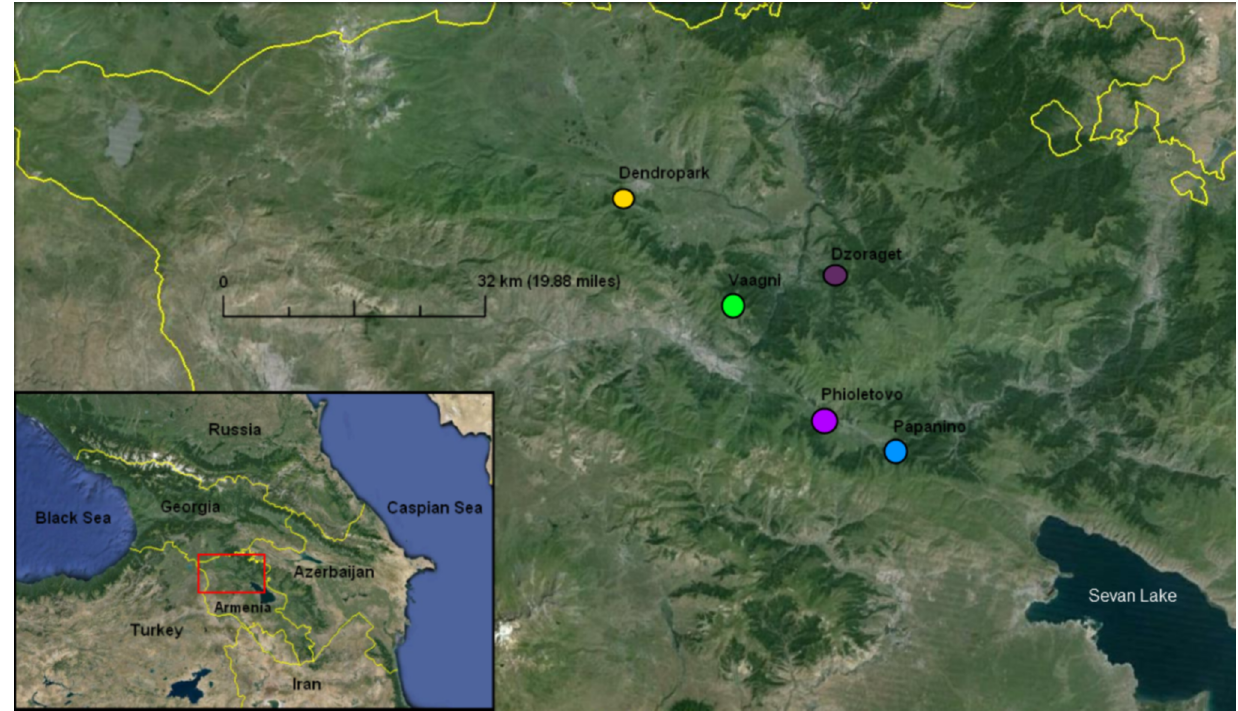
Figure 1. Map of Armenia with the distribution of localities from which parthenogenetic Darevskiadahli populations were collected. Sampling localities are indicated by different colours. Papanino ( + 40 u 42 9 27.76 0 , + 44 u 45 9 43.89 0 ), Phioletovo ( + 40 u 44 9 29.53 0 , + 44 u 39 9 31.25 0 ), Vaagni ( + 40 u 52 9 19.16 0 , + 44 u 31 9 28.60 0 ), Dzoraget ( + 40 u 54 9 15.02 0 , + 44 u 40 9 37.78 0 ), Dendropark ( + 40 u 59 9 30.55 0 , + 44 u 21 9 50.79 0 ).